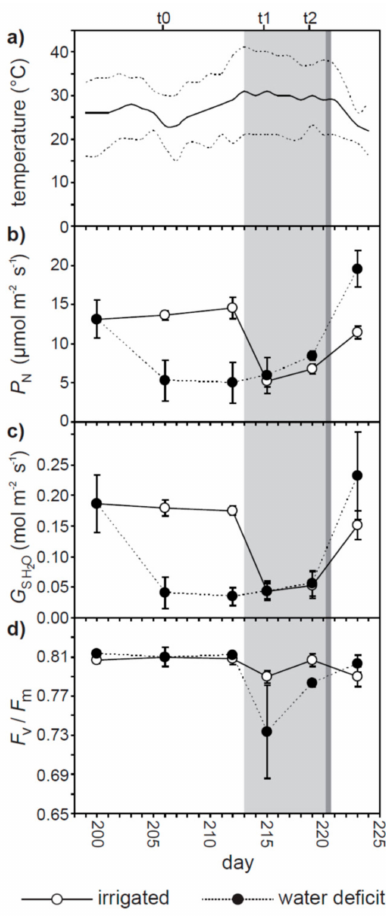
Figure 1. ( a ) Daily mean (solid black line), maximum and minimum (dashed lines either side of the mean) temperature during the experiment coinciding with the heat wave of summer 2017 (marked in light grey shading) which occurred from day 213 to 221. The darker grey shading marks the point at which the water deficit plants were ‘re-watered’ to receive full irrigation. Point measurements of photosynthesis ( P N ) ( b ), stomatal conductance ( G s H2O ) ( c ) and the maximum quantum efficiency of PSII ( F v / F m ) ( d ) of olive plants subject to full irrigation (white fill symbols, solid line) and water deficit (black fill symbols, broken line) were recorded at intervals during the experimental treatment. Error bars indicate one standard deviation either side of the mean. Time periods t0 (day 206), t1 (day 215) and t2 (day 219) marked above panel a refer to OJIP analysis in Figure